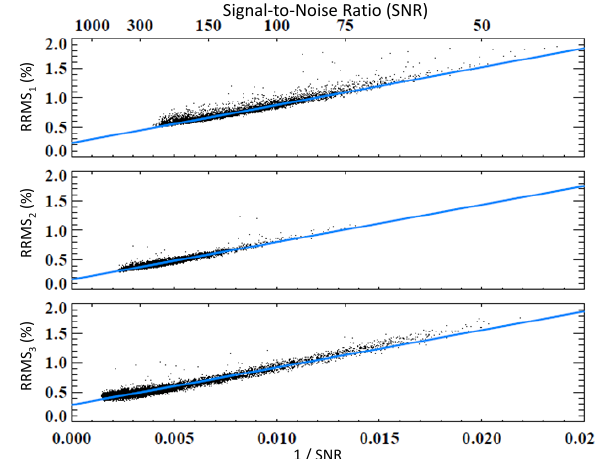
Fig. 7. Values of the relative root-mean-square (RRMS) of the residuals in the three TANSO-FTS SWIR bands are shown as a function of the inverse of the SNR for all GOSAT TANSO-FTS soundings collected over continents in July 2009 that converged, passed the cloud screen, and all other quality filters (black dots). A linear fit to each distribution of points is shown (blue line). If the RRMS were dominated by instrument noise or other random errors, the blue lines should go through the origin. The offset indicates the presence of systematic errors that do not decrease with increas- ing SNR. In B2.8, those errors are approximated as an “empirical